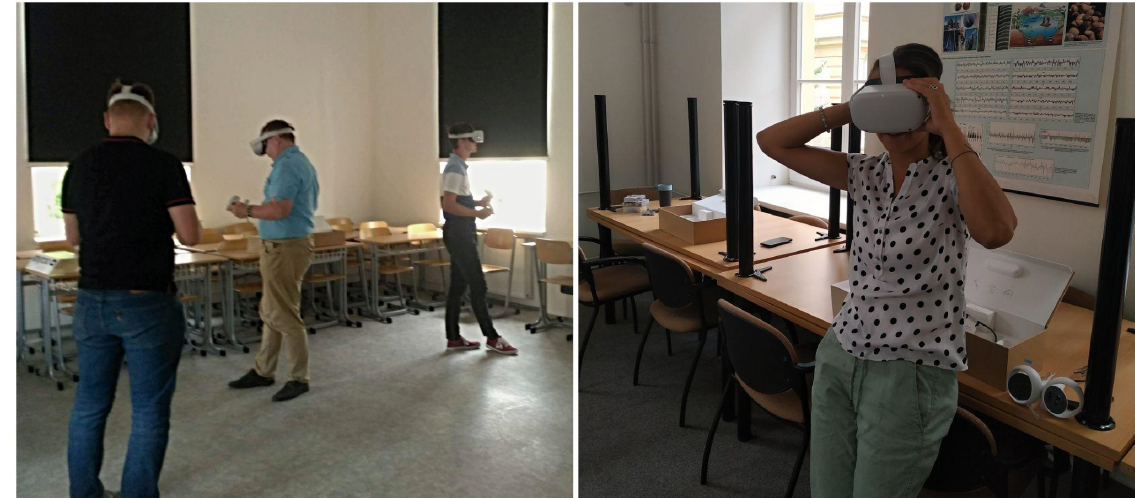
Figure 4. Participants in